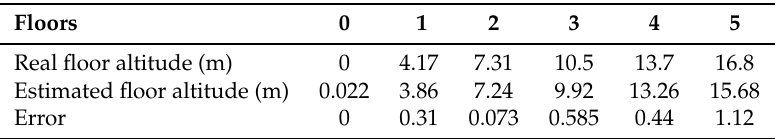
Table 8. Ground truth, estimated altitude and error for Building